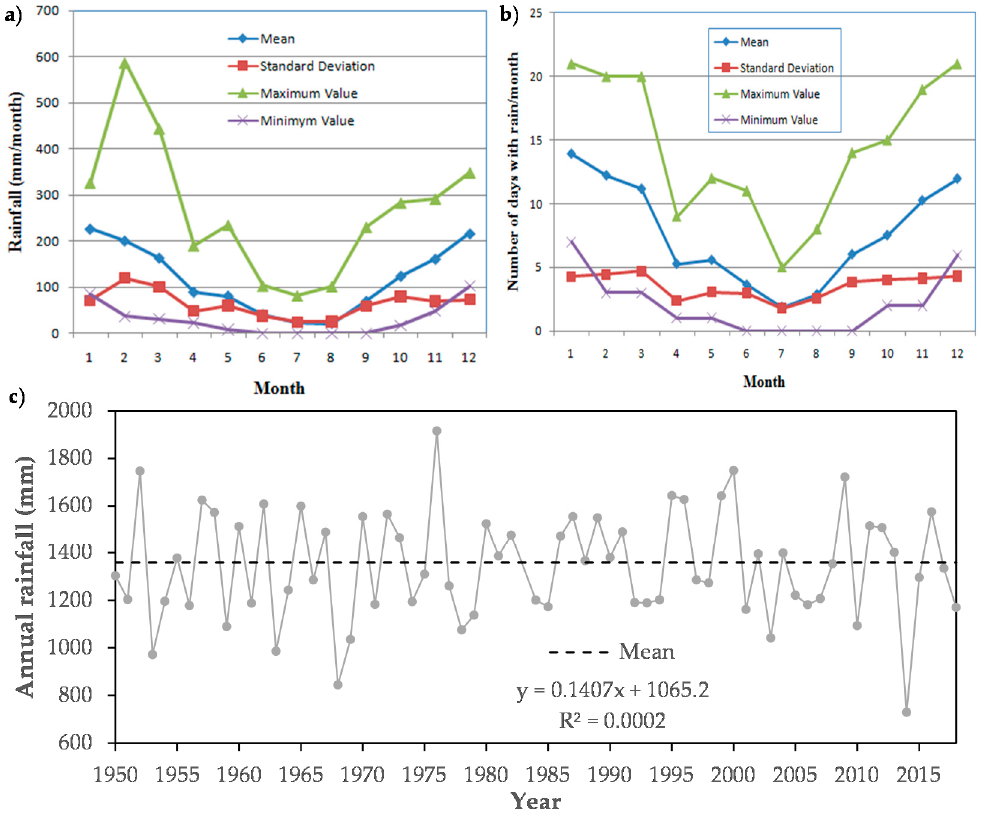
Figure 2. Mean rainfall / month ( a ) and number of days with rain / month ( b ) for the last 20 years and ( c ) annual rainfall from a 68-year series (1950–2018) in the study region.